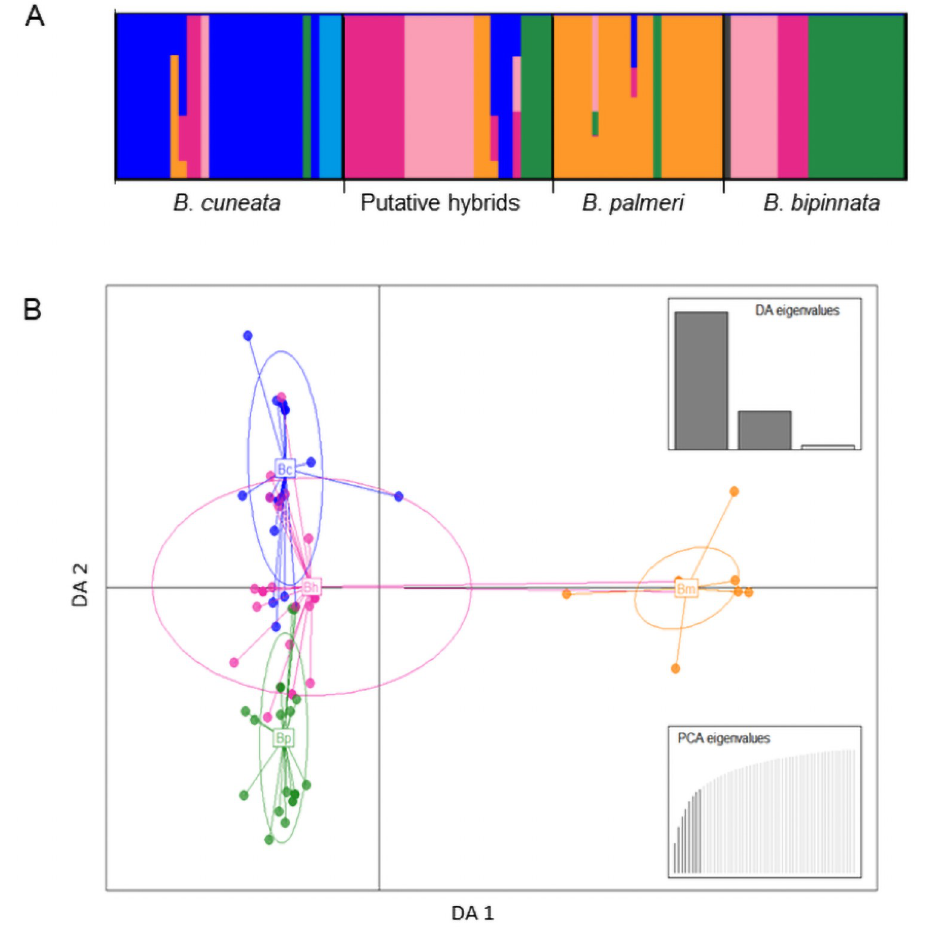
Fig 3. (A) BAPS barplot of the best-supported K = 7 clusters and (B) DAPC plot of haplotypes in Bursera bipinnata (Bp), B . cuneata (Bc), B . palmeri (Bm), and the putative hybrids (Bh). The insets showed the proportion of variance explained by each of the two DA eigenvalues (DA 1 & 2 respectively) and the number of retained PCA